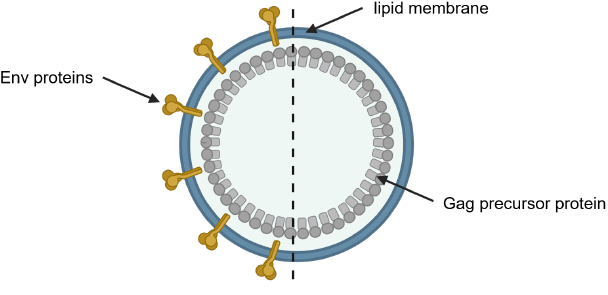
Figure 1. Schematic illustration of a membrane-enveloped HIV VLP. The protein core of immature HIV VLPs is composed of unprocessed Gag precursor proteins (grey) and surrounded by the lipid bilayer of the expression cell (blue). Envelope glycoproteins (Env) proteins are shown in yellow on the VLP, representing a decorated HIV VLP (left) and a bald VLP without decoration (right). Created with